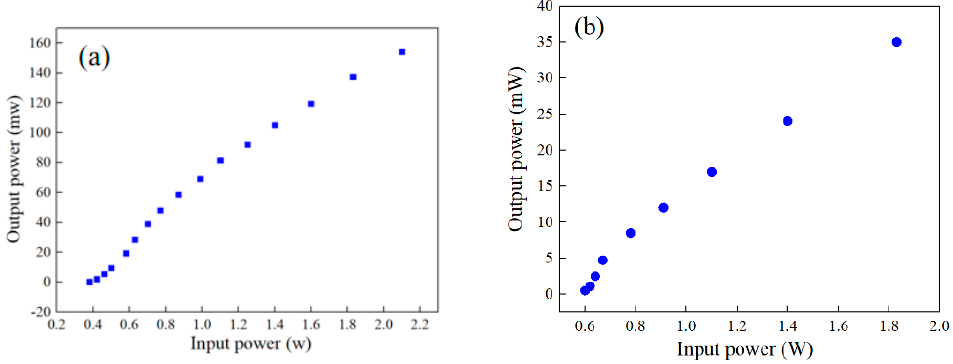
Figure 6. The output power versus the input power ( a ) without F–P etalon ( b ) with F–P etalon. Simultaneously, the output spectrum of the signal laser with the pump power of 1.83W is plotted in Figure 7 when the proposed F-P etalon is absent. The spectrum is an- alyzed by the spectrograph (bought from Shenzhen Zeruiguang company of China, An- ristu MS9740A) with a resolution of 0.03 nm, and the spectrum width of the signal laser is about 0.5 nm. It can also be seen that the beam quality has great potential to be improved.